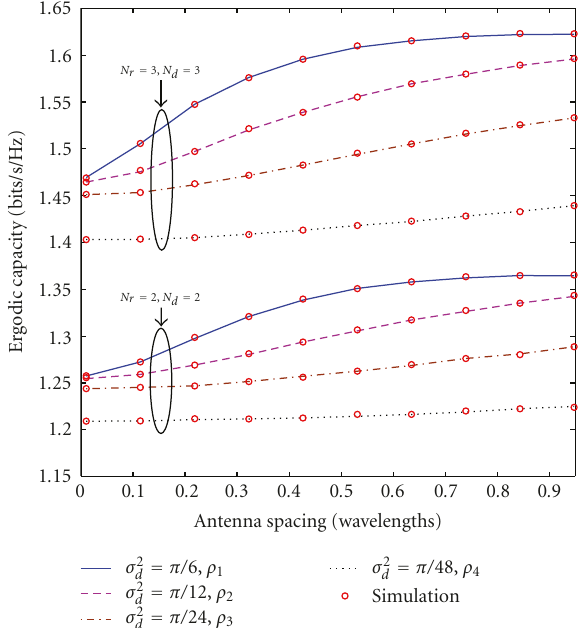
Figure 5: The impact of correlation coe ffi cient of source-to-relay channels and antenna spacing/angular spread at the destination on = γ the ergodic capacity. γ / 2 = 10dB. θ = π/ 4. For N r = 2, the 1 2 = S → R semiarbitrary correlation matrix is parameterized by ρ 1 = [0 . 4,0 . 45], ρ = [0 . 6,0 . 65], and ρ = [0 . 8,0 . 85]. [0 . 2,0 . 25], ρ 2 3 4 = For N r = 3, S → R correlation matrix is parameterized by ρ 1 = [0 . 45,0 . 5,0 . 45], ρ = [0 . 6,0 . 65,0 . 55], and ρ = [0 . 2,0 . 25,0 . 3], ρ 2 3 4 [0 . 85,0 . 8,0 .